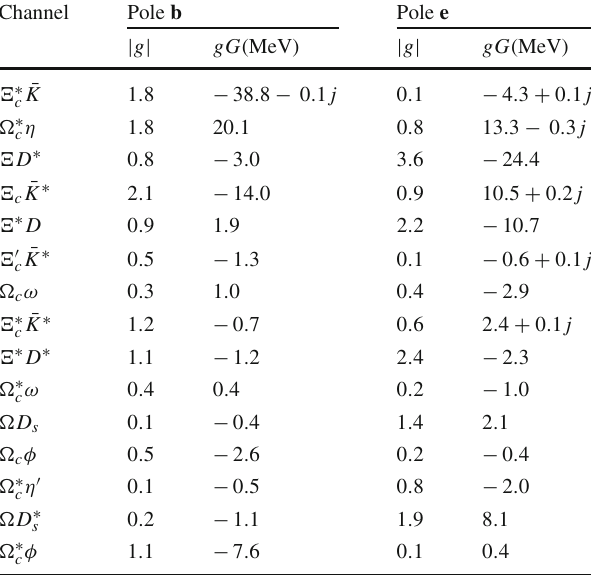
Table 6 J = 3 / 2 (cid:2) ∗ c states, labeled as poles b and e , calculated using the subtraction constants determined by a unique UV cutoff (cid:3) = 1090 MeV (see Eq. (13)). The first column displays the different baryon-meson coupled channels, ordered by their threshold energies, for J = 3 / 2. The subsequent columns show the absolute value of the coupling and the product of the coupling with the loop function at the pole for all baryon-meson coupled states for pole b at 3048.7 MeV (second and third columns) and pole e at 3155.37 MeV (fourth and fifth columns). Pole b at 3048.7 MeV might be identified with the